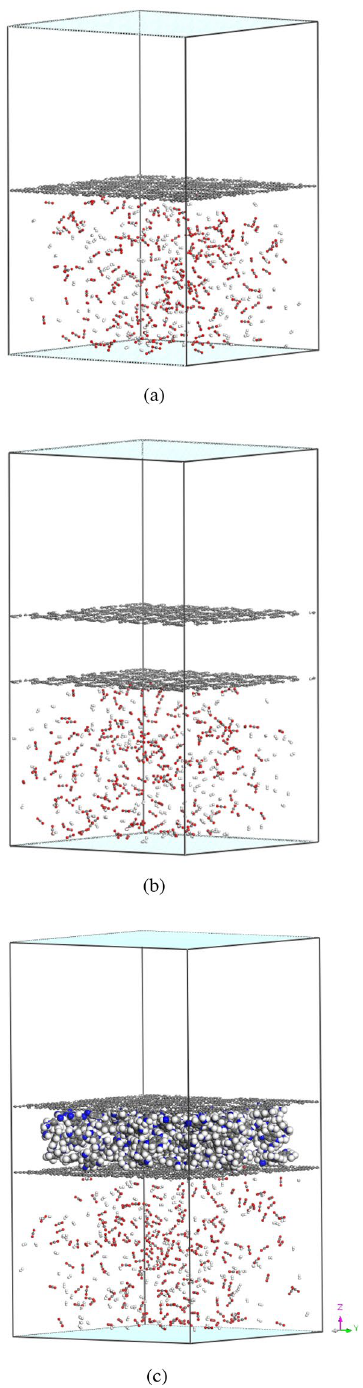
Figure 6. MD simulated configurations of the H 2 and CO 2 gas particles passing through the GDY-H membrane: ( a ) monolayer, ( b ) two layers and ( c ) two layers of the membrane in the presence of 1,3,5-TAB. The height of simulation boxes are 10, 12 and 12 nm,